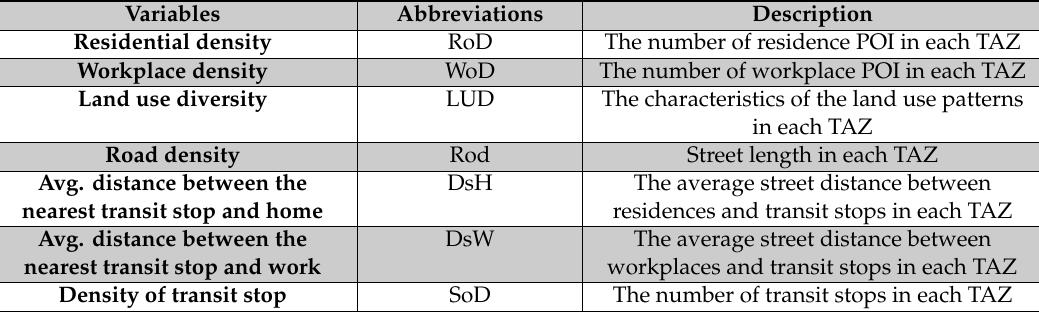
Table 1. Explanations of the abbreviations for the built environment variables. POI: points of